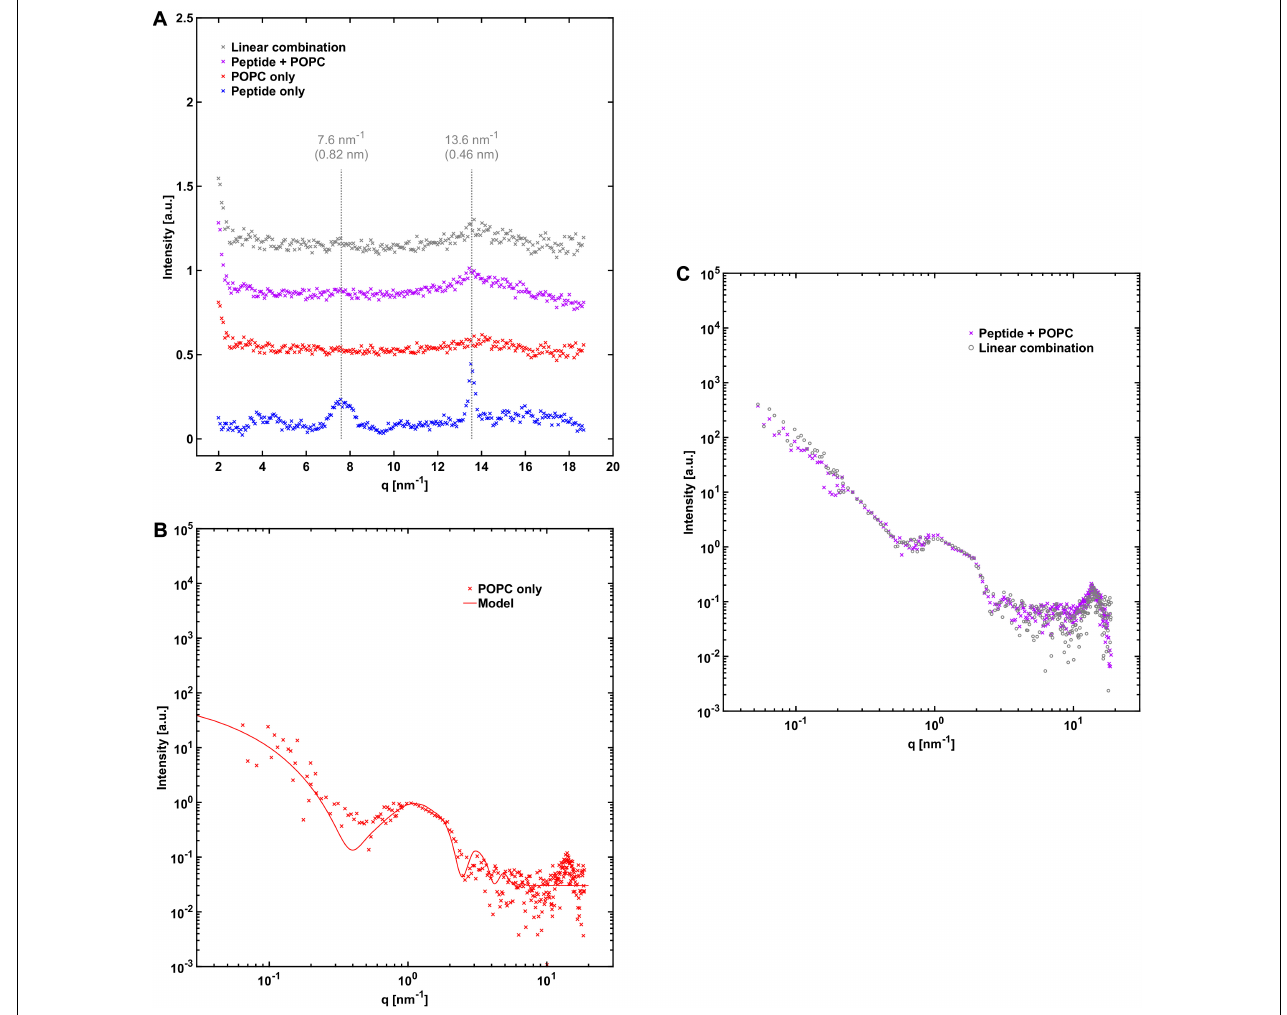
FIGURE 5 | NACore together with POPC. (A) WAXS profiles similar to those in Figure 4A , except that POPC was used instead of POPC:POPS. (B) 2.4 mM POPC without the peptide together with a simple vesicle model fit with 90% unilamellar and 10% bilamellar vesicles (see Supplementary Table 1 ). (C) SAXS profile of NACore co-incubated with POPC, together with a linear combination of scattering from peptide fibrils ( Figure 3B ) and POPC vesicles (B) (0.15 · fibrils + 1.40 · vesicles).